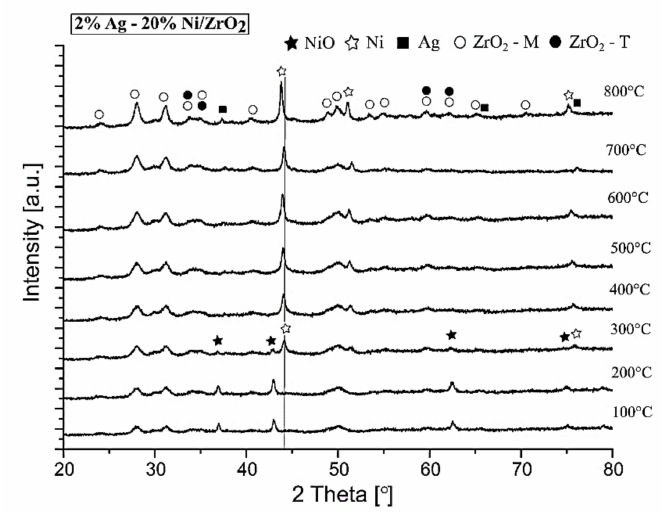
Figure 10. Powder patterns recorded for the 2% Ag-20% Ni catalysts during the reduction process, performed in a hydrogen atmosphere in the temperature range 100–800 ◦